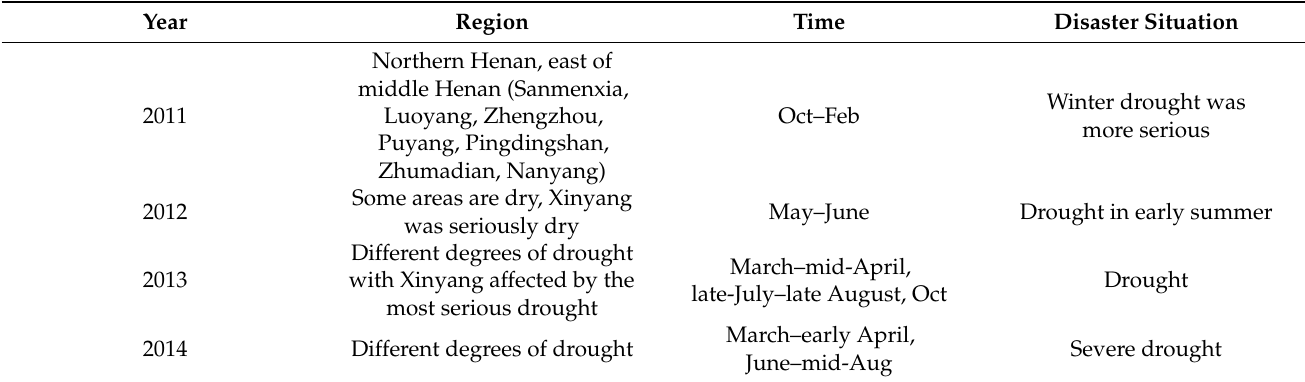
Table 5. Summary of the drought disasters in Henan Province in the period